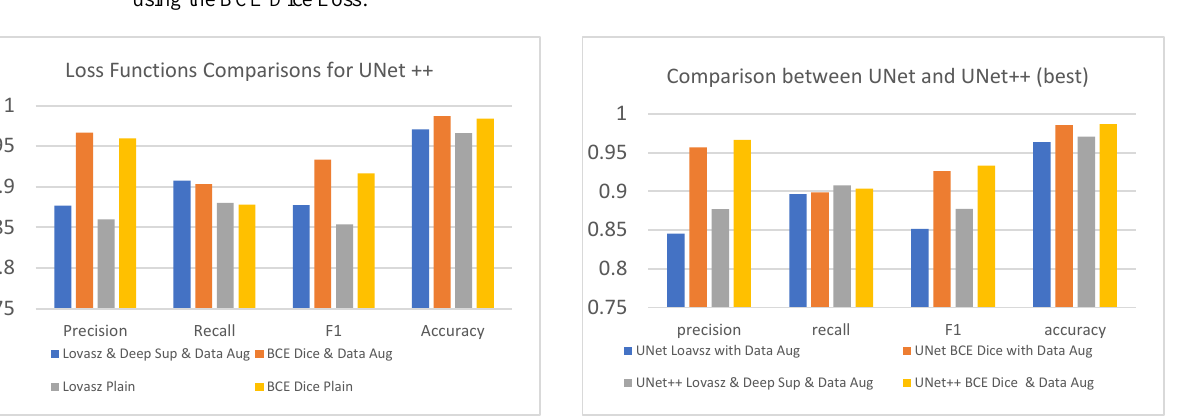
Figure 5: Comparison of the effects of using different loss functions on the UNet++ test results.